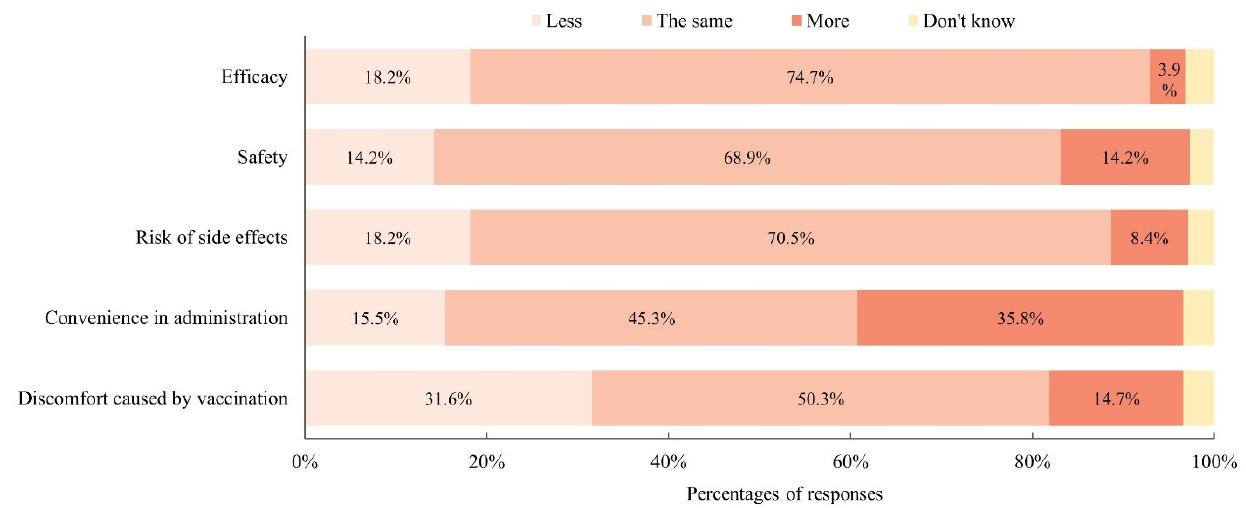
Figure 1. Perceptions of LAIV versus IIV among the participants ( N = 380).